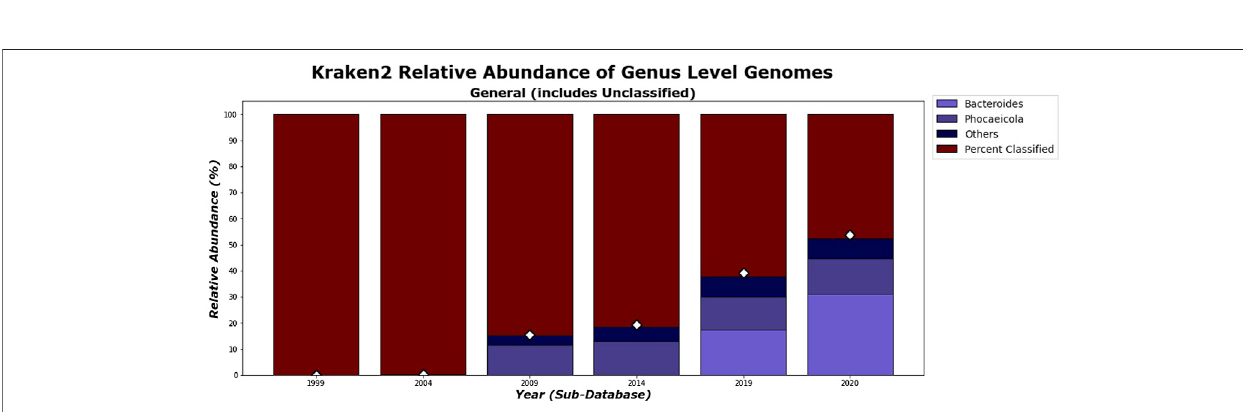
FIGURE11| Kraken2 ’ sgeneralrelativeabundanceforGenuslevel.Onlytaxawhosegeneralrelativeabundancewasatleast3%areshownasacoloredbarhere. A bar for the unclassi fi ed group is included. The percentage of classi fi ed reads for each year are shown as diamond markers.